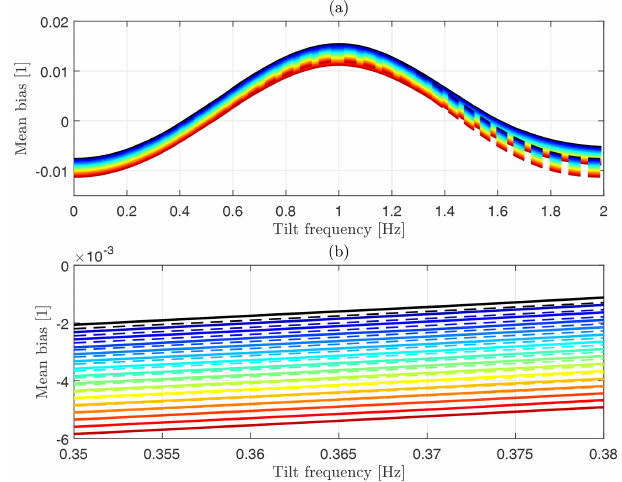
Figure 8. (a) Mean bias caused by roll motion as function of oscilla- tion frequency f p for amplitude of motion A = 10 ◦ without (black) and with consideration of wind shear characterized by shear coef- ficients α = 0 . 01 (blue) to 0.15 (red). (b) Enlarged visualization of plot above for 0 . 35 ≤ f p ≤ 0 .